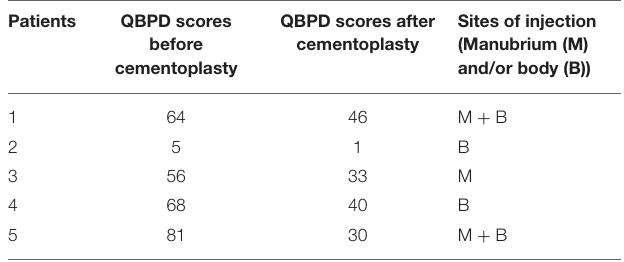
TABLE 2 | Patients’ scores from the Quebec back pain disability scale before and after the intervention. Patients QBPD scores before